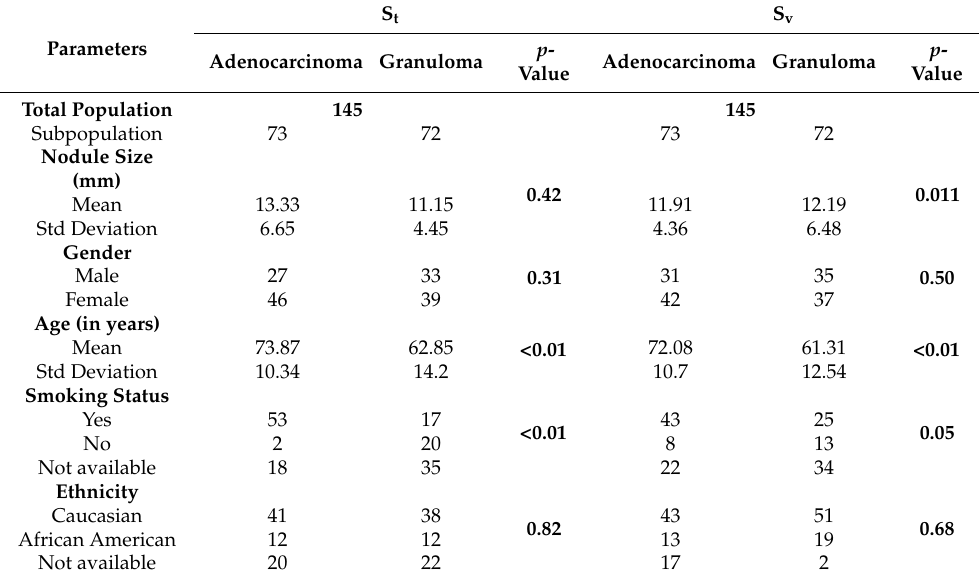
Table A3. Details of the distribution of the granulomas and adenocarcinomas within the training and validation sets. p -values indicate the statistical significance between patients parameters and disease outcome for both training and validation cohorts. The p -values were computed using Students t test for continuous variable and Fishers exact test for categorical data.